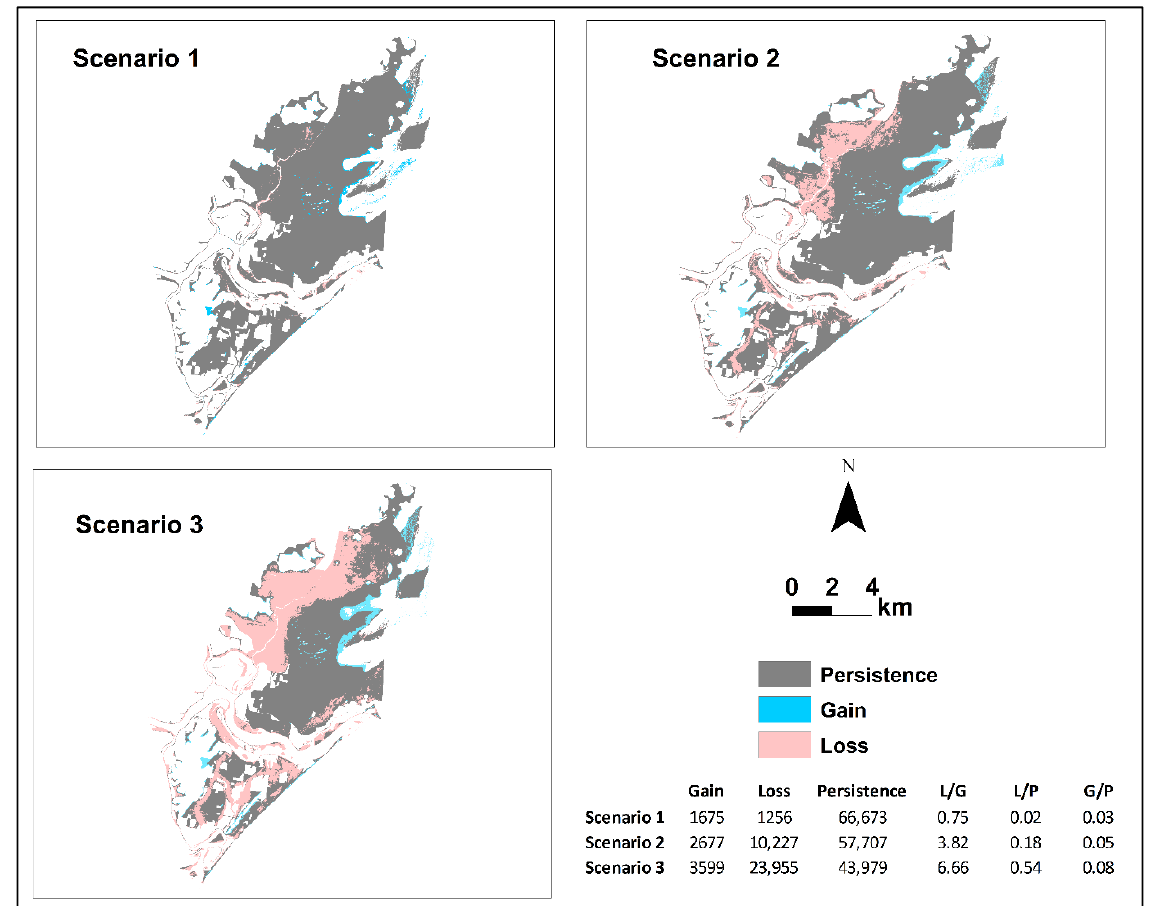
Figure 4. Wetland loss and gain under SLR scenarios (SLR scenarios 1, 2, and 3 correspond to 0.5 m, 1.0 m, and 1.5 m SLR, respectively). A summary of the areal changes (ha) and ratios between loss and gain, loss and persistence, and gain and persistence are extracted from the maps and also listed. Note that water and terrestrial vegetation were masked out to focus on wetland changes.